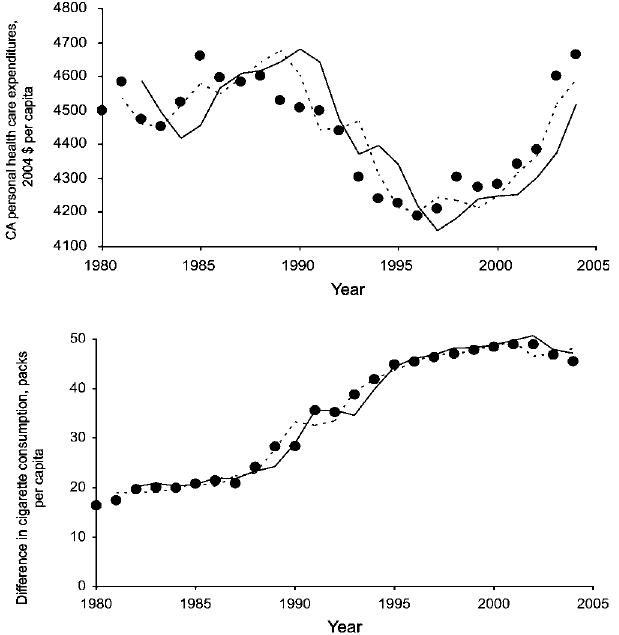
Figure 1. California Personal Health Care Expenditures and Difference in Cigarette Consumption between Control States and California Endogenous variables per capita California personal health care expenditures h CA,t (top graph), and difference in per capita cigarette consumption between the control states and California, ( s control,t (cid:2) s CA,t ) (bottom graph), are generated from the estimated model equations and observed exogenous variables using dynamic predictions, and follow the observed values (dots) of the dependent variables closely. The dotted lines are the predicted long-run cointegrating relationships (Equations 1 and 3) and the solid lines add the short-run fluctuations from the ECM (Equations 2 and 4) to the long-run predictions.